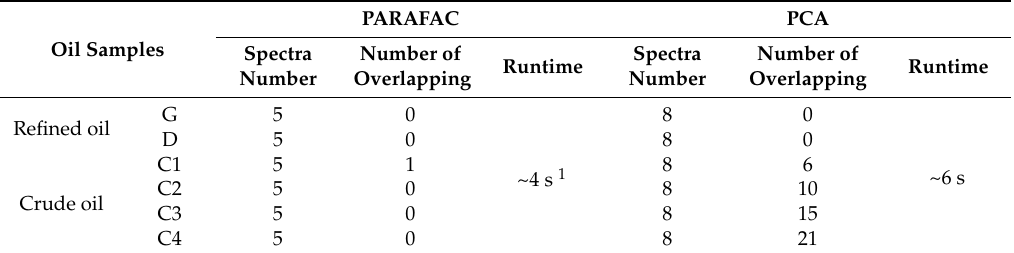
Table 3. Comparison of identification results using parallel factors analysis (PARAFAC) and principal component analysis (PCA)